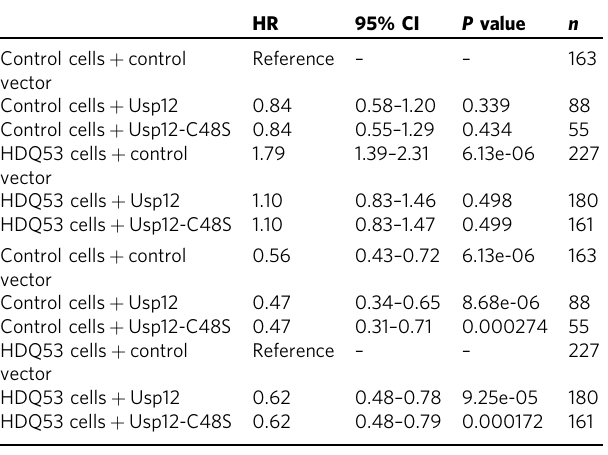
Table 3 Cox proportional hazards analysis of non-catalytic Usp12 effect on survival of patient-derived iPSC- differentiated